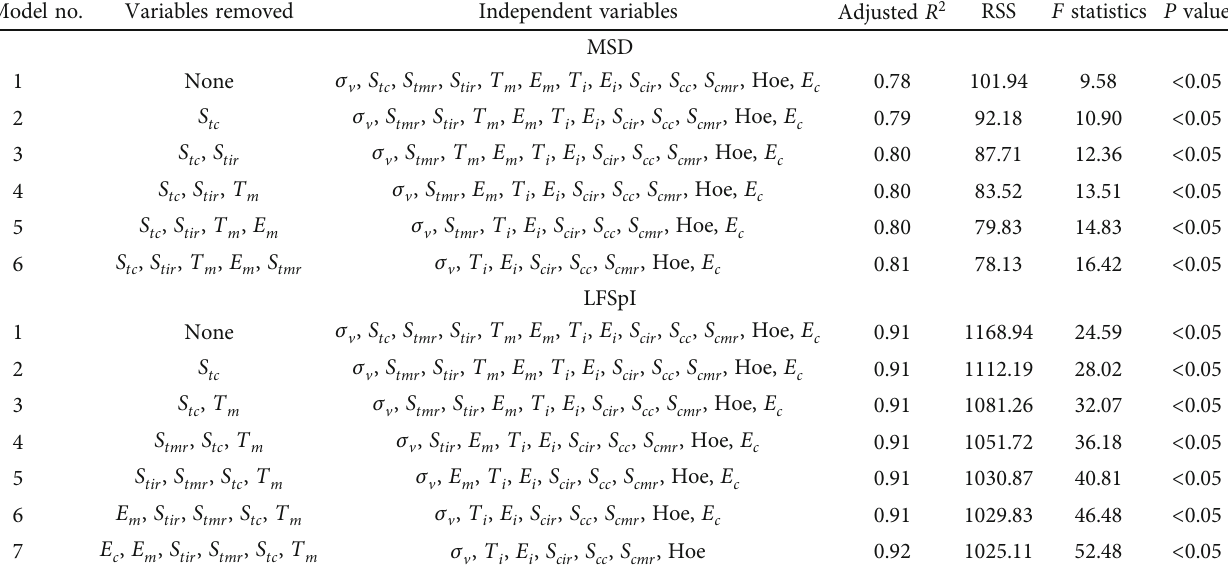
Table 5: Selection of independent variables for regression model.